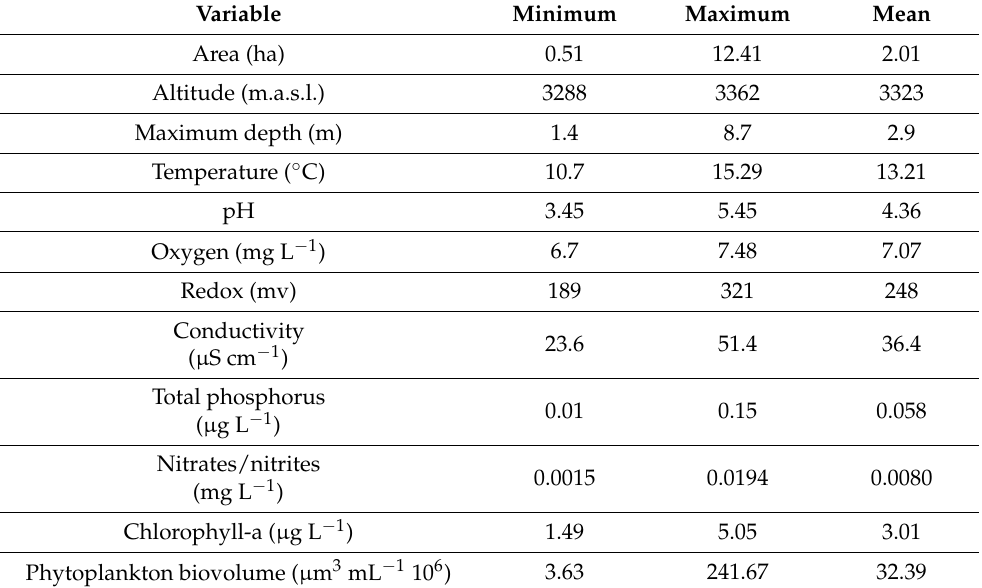
Table 1. Overview of the geographic, physicochemical, and biological variables measured along the 24 lakes included in the